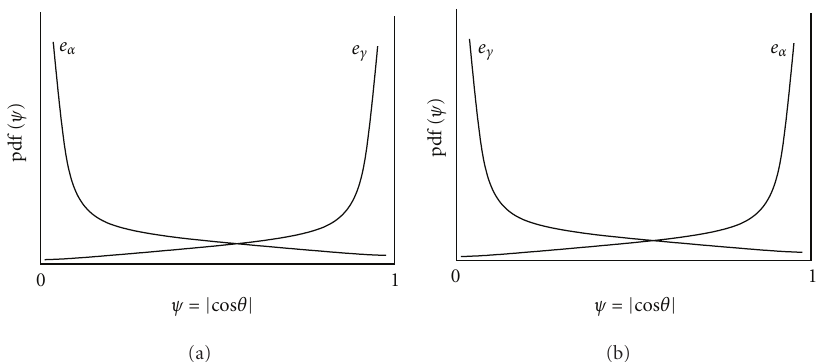
Figure 1: Schematics showing the alignment of scalar gradient with the two principal components of turbulent strain rate tensor ∇ u in (a) nonreacting turbulence and (b) turbulence with premixed combustion. The most extensive and compressive principal strain rates are noted respectively as e α and e γ